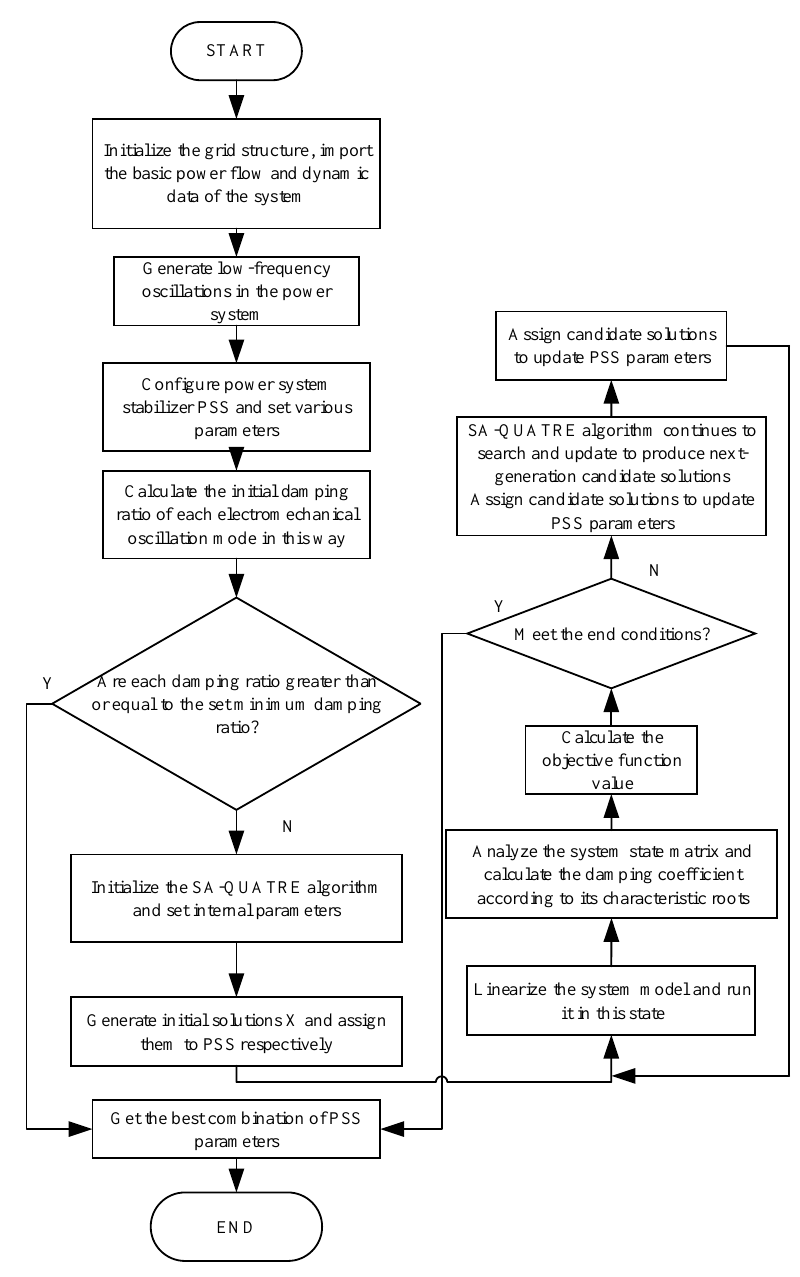
Figure 4. Flow chart of optimizing PSS parameters by SA-QUATRE